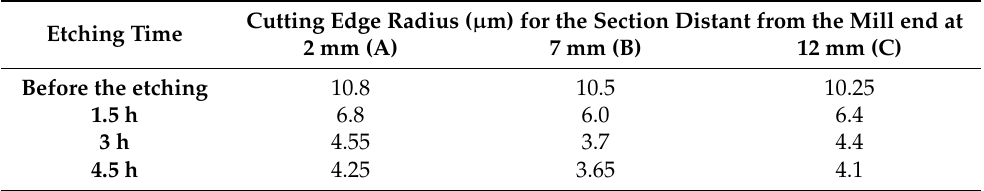
Table 2. Cutting edge radii after etching the end mills.